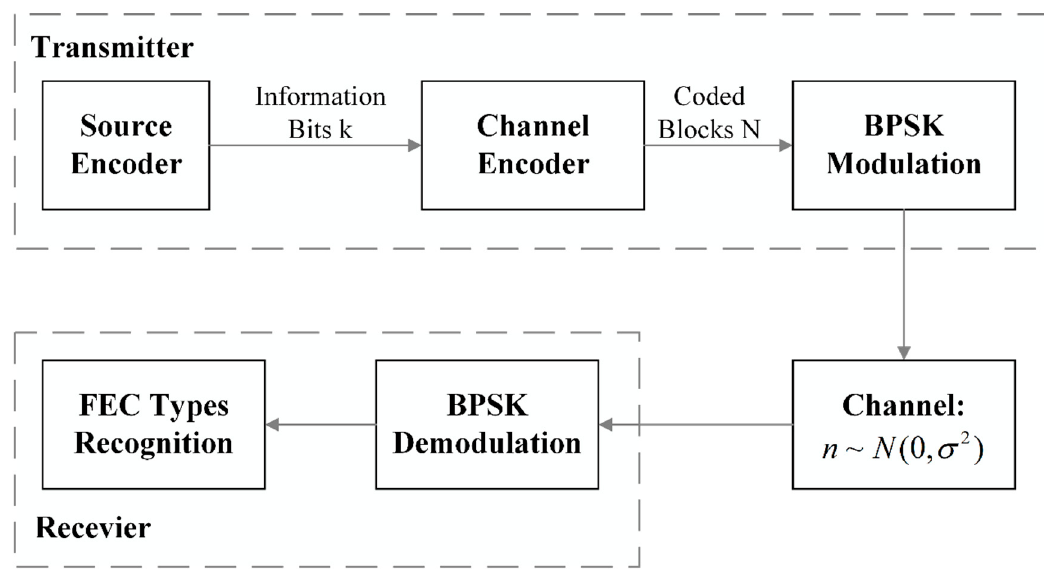
Figure 1. General block diagram of the blind recognition.